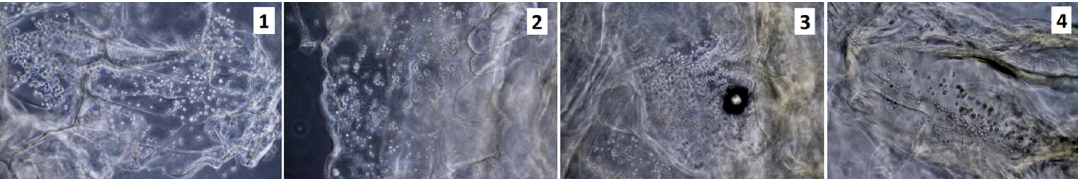
Figure 12. Uncoated with fibronectin, scaffolds sterilized with ethylene oxide, rinsed in antibiotics; 3rd of the cell culture (sample 1—chitosan crosslinked with adipic and malonic acid; sample 2—chitosan crosslinked with adipic and L -glutamic acid; sample 3—chitosan crosslinked with adipic, L -glutamic and malonic acid; sample 4—chitosan crosslinked with adipic and levulinic). Molecules 2017 , 22 , x FOR PEER REVIEW